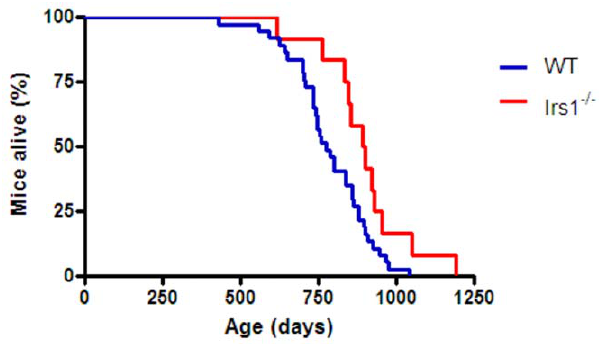
Figure 2. Male Irs1 2 / 2 mice are significantly long-lived. Kaplan- Meier survival curves for male WT and Irs1 2 / 2 mice. Blue and red lines indicate WT and Irs1 2 / 2 mice respectively.